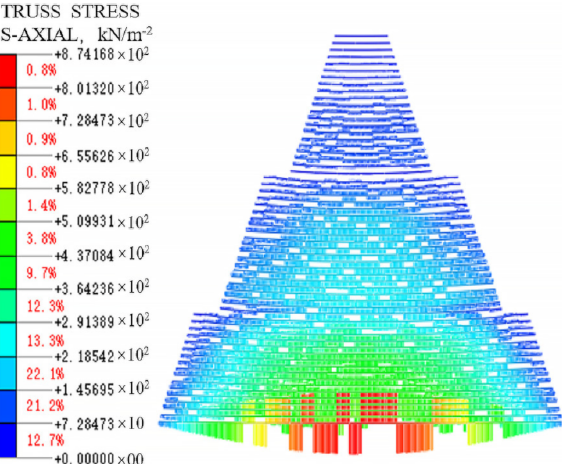
Figure 15. Geogrid stress cloud.